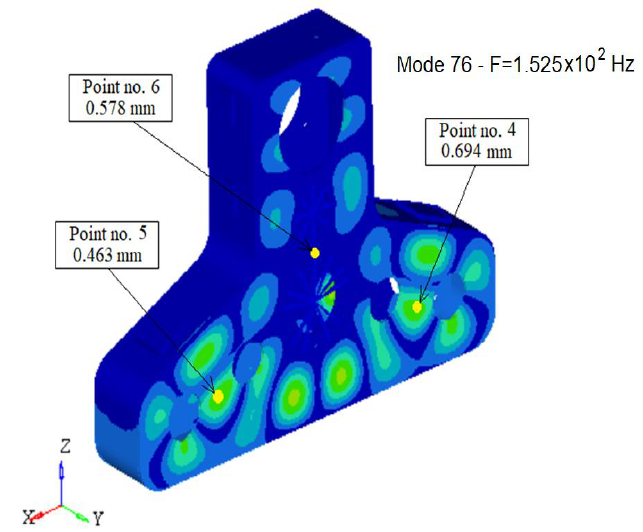
Figure 15. Displacements of the points on the rear surface of the housing for mode 76.